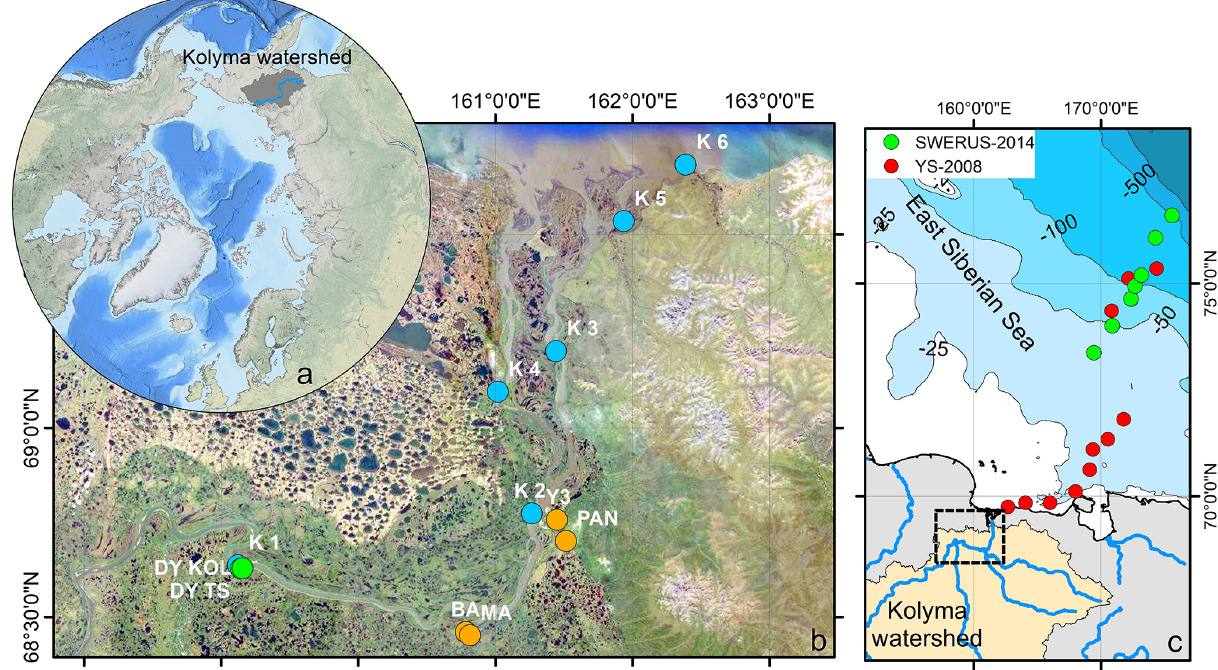
Figure 1. (a) Location of the Kolyma watershed (Made with ArcMap™, © Esri. All rights reserved.). (b) Kolyma River delta with sample locations. In blue the Kolyma mainstem samples, orange the tributaries (Panteleikha (PAN), Bolshoy and Maly Anyuy (BA and MA), and Y3), green Duvanny Yar (DY). For reference, location K 2 is at the town of Cherskiy. Background image adapted from Mann et al. (2012). (c) Sample location in the East Siberian Sea following the Kolyma paleoriver-transect, extended to the shelf break. In red, the first eight locations offshore from South to North: YS34B to YS41 (Vonk et al., 2010a; Tesi et al., 2014); four locations farther offshore from South to North: YS91, YS90/SWE-63, YS88, YS86. In green, south to north: SWE-60, SWE-61, YS90/SWE-63, SWE-64, SWE-65, SWE-66, and SWE-67 (Salvadó et al., 2016; Bröder et al., 2019). The black box shows the location of panel (b) .